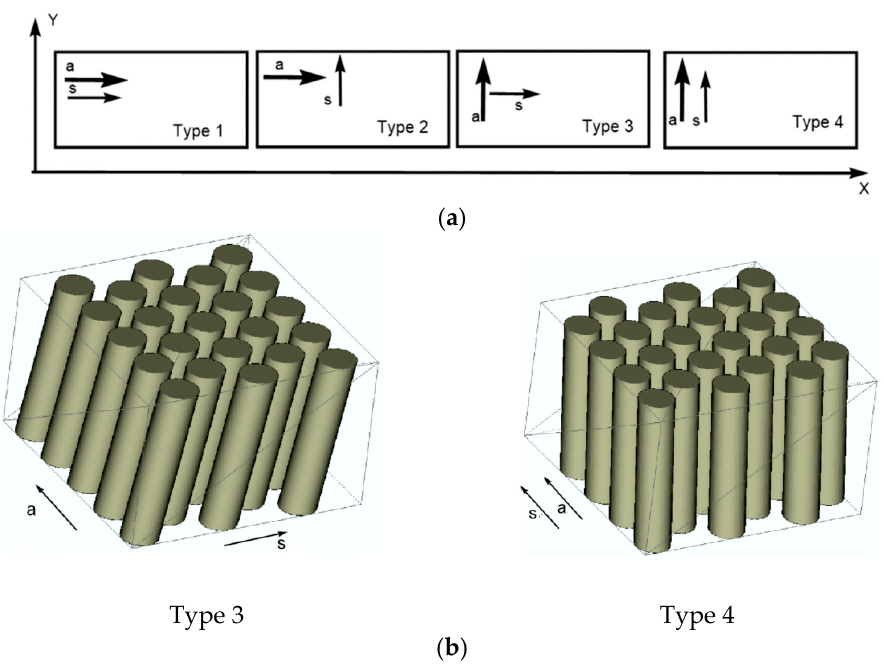
Figure 9. Different types of regular packing of sections for the same geometry: ( a ) diagram of four types of sections; ( b ) examples of two types of sections for the same geometry.